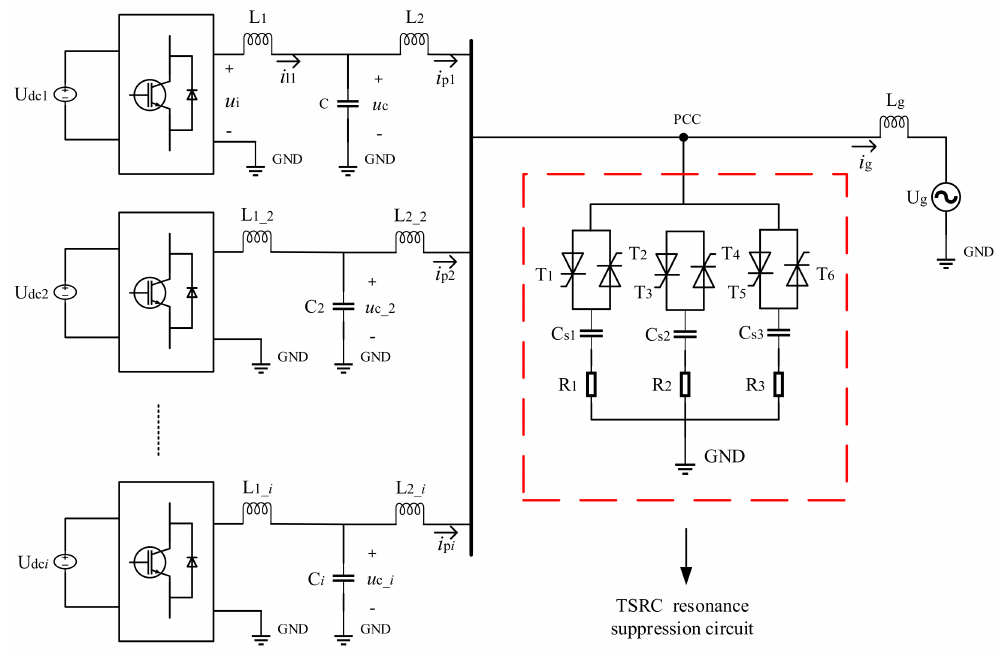
Figure 10. TSRC resonance suppression schematic of grid-connected inverter